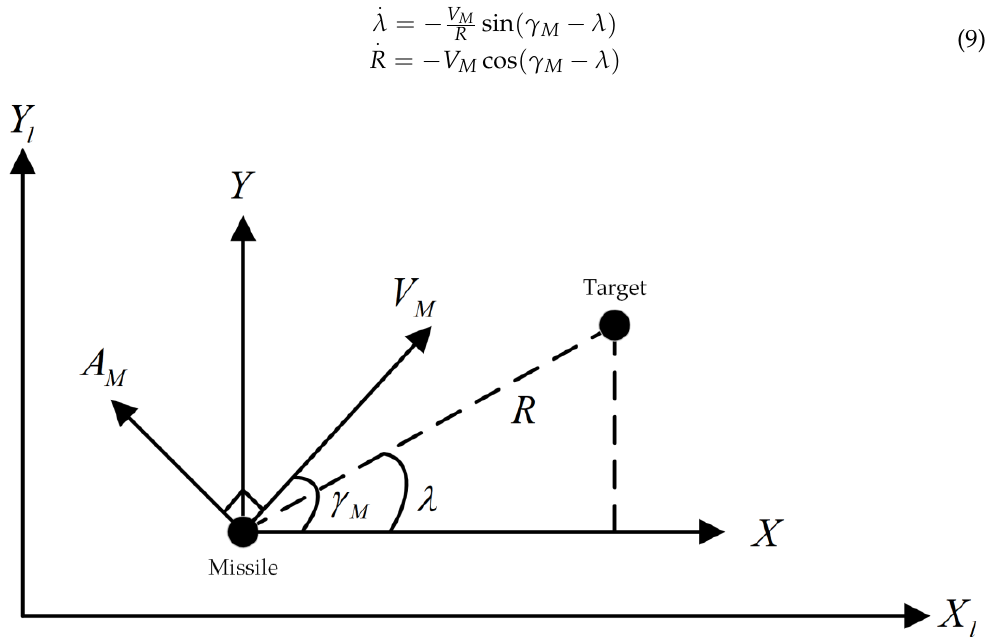
Figure 4. Engagement kinematics between the missile and target.